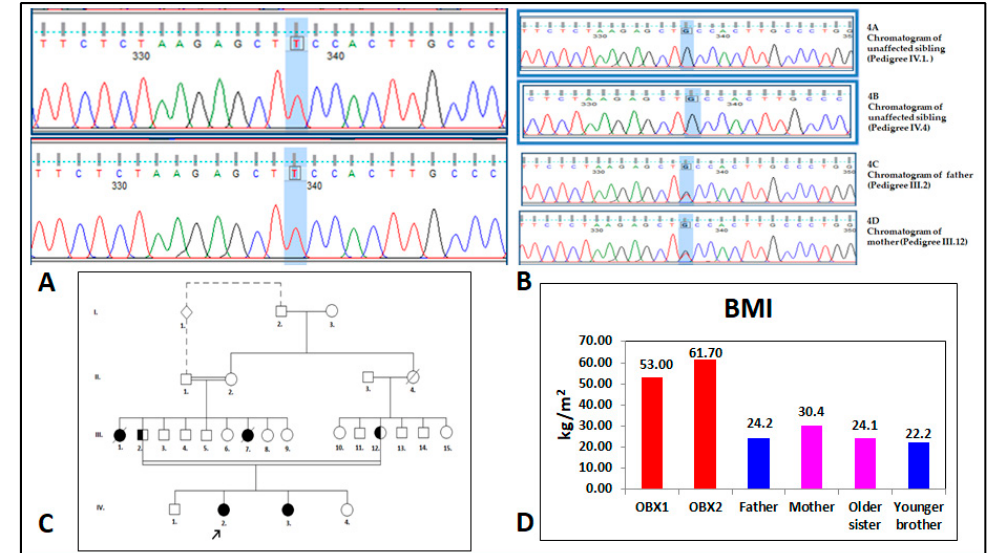
Figure 2. ( A ) DNA sequencing chromatogram indicating leptin ( LEP ) gene homozygous mutation c.350G>T (p.Cys117Phe) in severely obese sisters OBX1 and OBX2. ( B ) DNA sequencing chromatogram indicating LEP gene homozygous mutation c.350G>T (p.Cys117Phe) in the father and mother